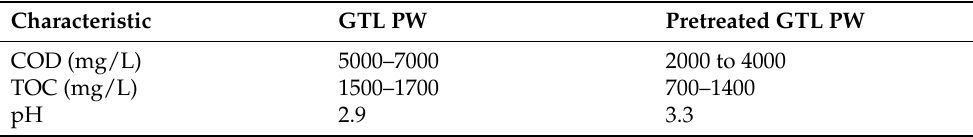
Table 1. The physical and chemical characteristics of